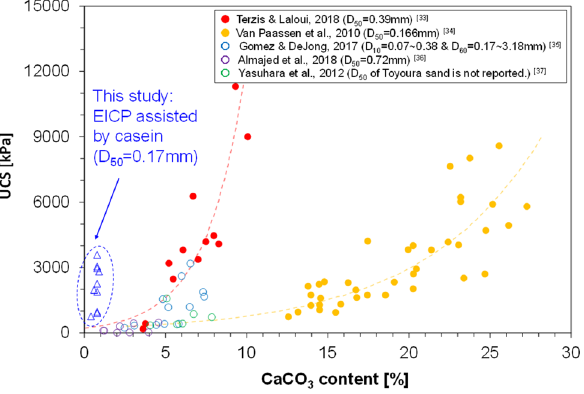
Figure 2. Unconfined compressive strength (USC) versus calcium carbonate (CaCO 3 ) content in the specimens treated using biocementation in the literature and using EICP in this study.